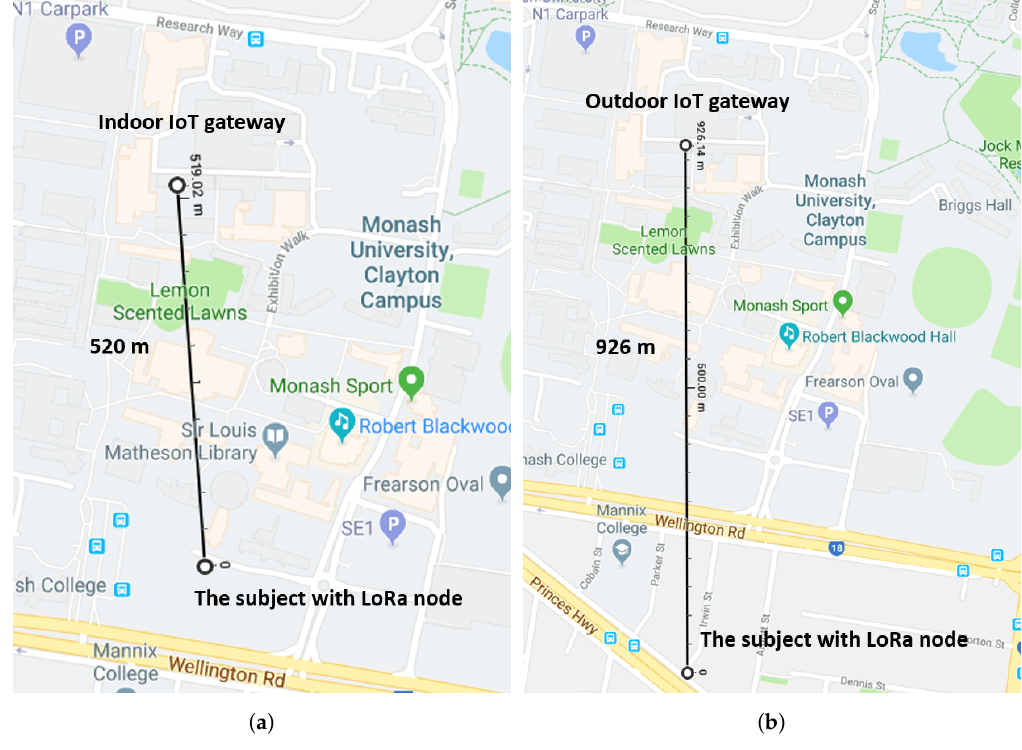
Figure 8. The coverage range of the IoT gateway: ( a ) indoor; ( b )